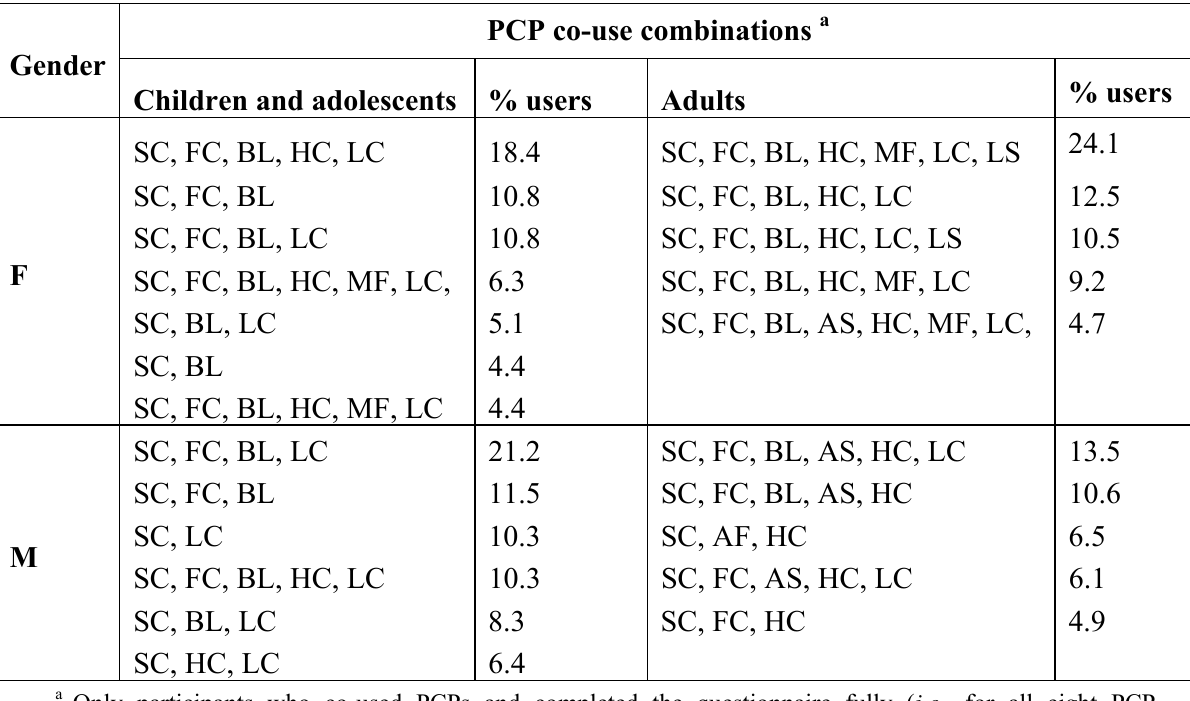
Table 3. Five most frequent PCP co-use combinations for the eight investigated PCP